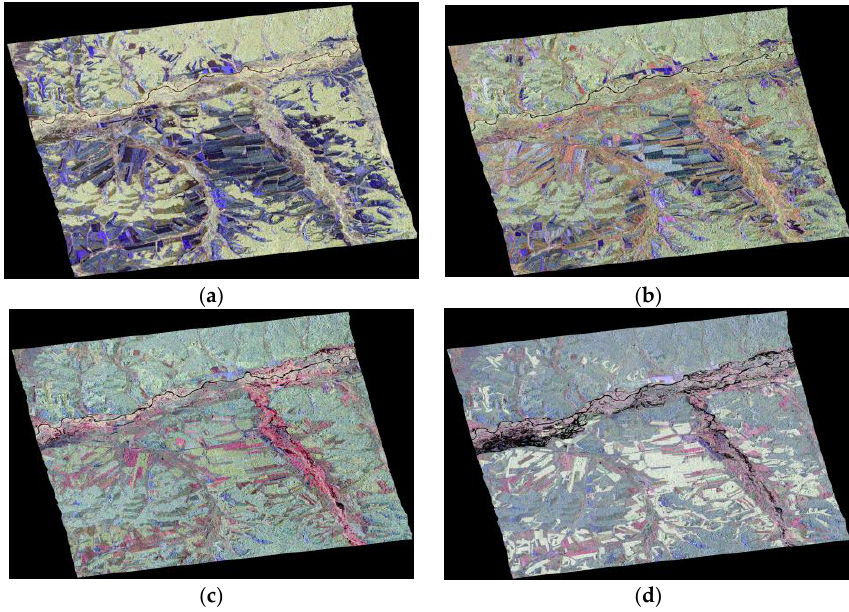
Figure 8. Time series analysis of backscatter coefficient on RADARSAT-2 data sets for Yigen: ( a ) 23 May 2013; ( b ) 6 June 2013; ( c ) 10 July 2013; and ( d ) 3 August 2013.